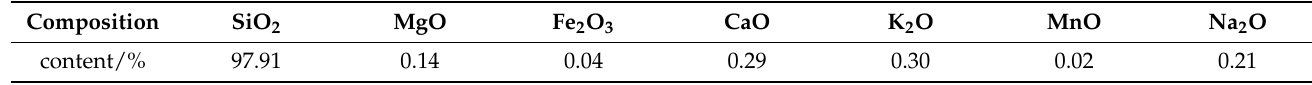
Table 3. Chemical composition of silica fume.